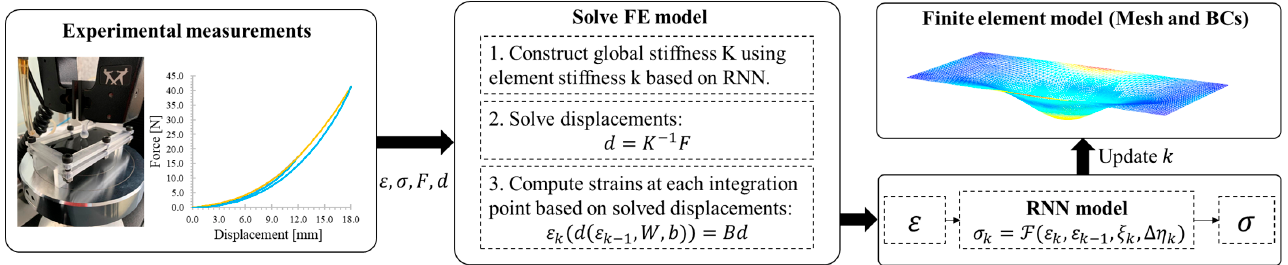
Figure 5. The framework of RNN–FE coupled approach based on experimental data (loading shown in yellow and unloading shown in blue).